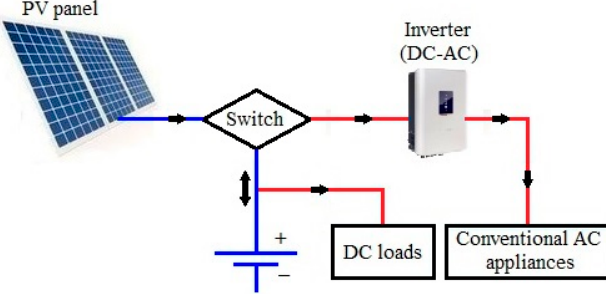
Figure 5. Diagram of a stand-alone photovoltaic (PV) system.